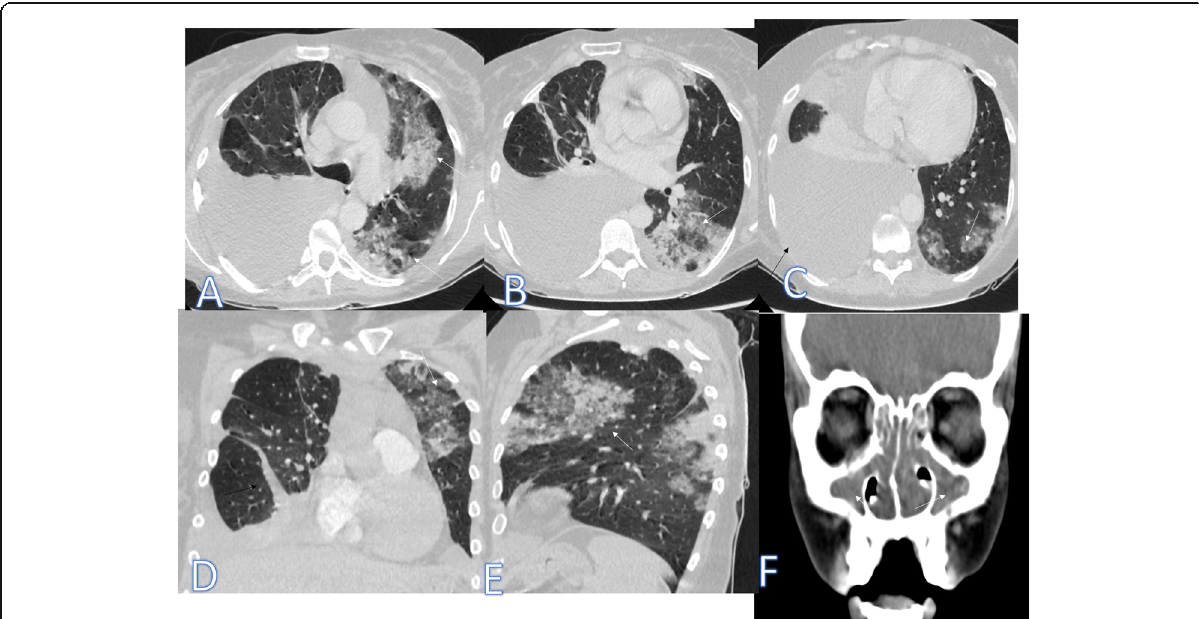
Fig. 16 A 39-year-old asthmatic female patient presented with shortness of breath with cough and dyspnea. CT showed multiple consolidative patches with GGO and crazy paving appearance (white arrows) and moderate right pleural effusion (black arrow). CT paranasal sinus ( f ) showed bilateral total opacifications of the sinus (arrow). The diagnosis was Churg-Strauss syndrome